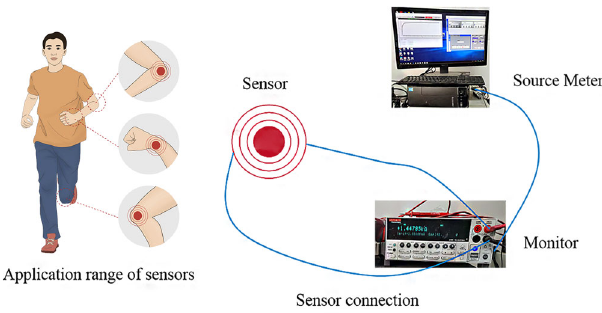
Fig. 7 The sensing application of strain sensors and the composition and signal conversion process of strain sensors. After receiving the human motion signal, the sensor is monitored by the detector (monitor; source meter), and then processed by the processor (computer) and converted into a digital